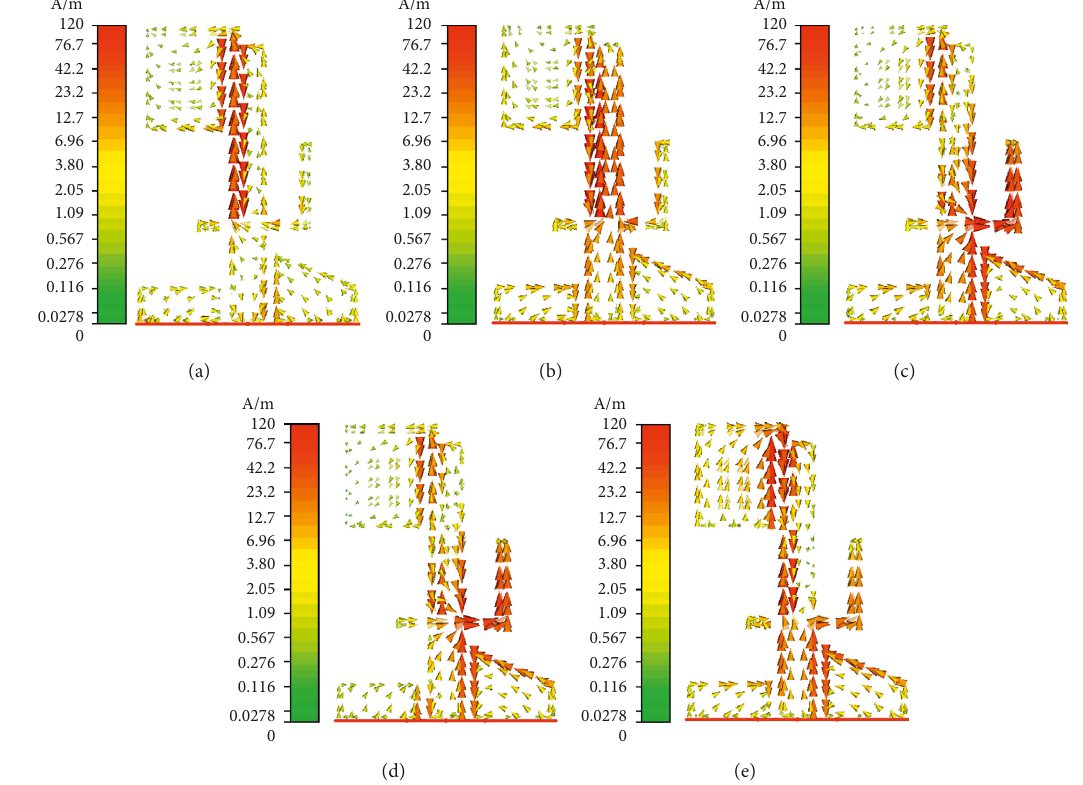
Figure 8: Simulated surface current distribution of the WLAN/WiMAX triband antenna at (a) 2.4, (b) 3.5, (c) 5.2, (d) 5.5, and (e) 5.8